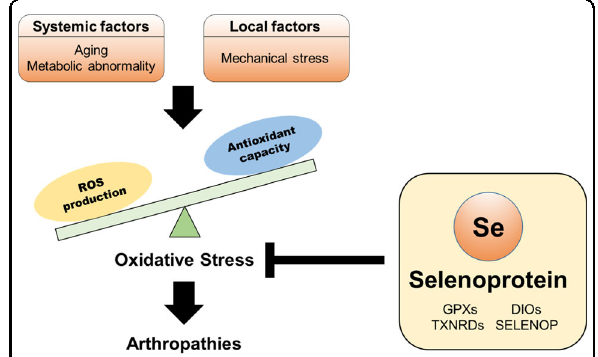
Fig. 2 The protective function of selenoproteins against imbalanced redox homeostasis and the progression of arthropathies. Oxidative stress induced by systemic and local factors causes arthropathies, and selenoproteins play protective roles in the maintenance of redox homeostasis. OA, one of the most common forms of arthropathies, is related to multiple etiologies involving systemic factors and local factors such as aging, metabolic abnormality, and mechanical stress associated with overuse, injury, and misalignment. These OA-causing factors disrupt the balance between ROS production and antioxidation, thereby resulting in accumulation of oxidative stress. The dysregulation of redox homeostasis causes the disruption of cartilage homeostasis and leads to the development of arthropathies such as KBD and OA. Restoring redox homeostasis through the activation of selenium metabolism and supplementation with selenoproteins can be a rational therapeutic strategy to treat